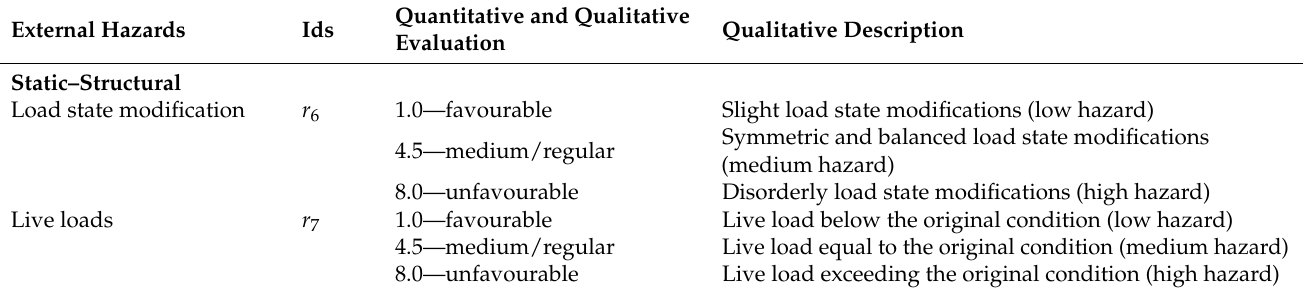
Table 3. Input variables descriptions related to external hazards